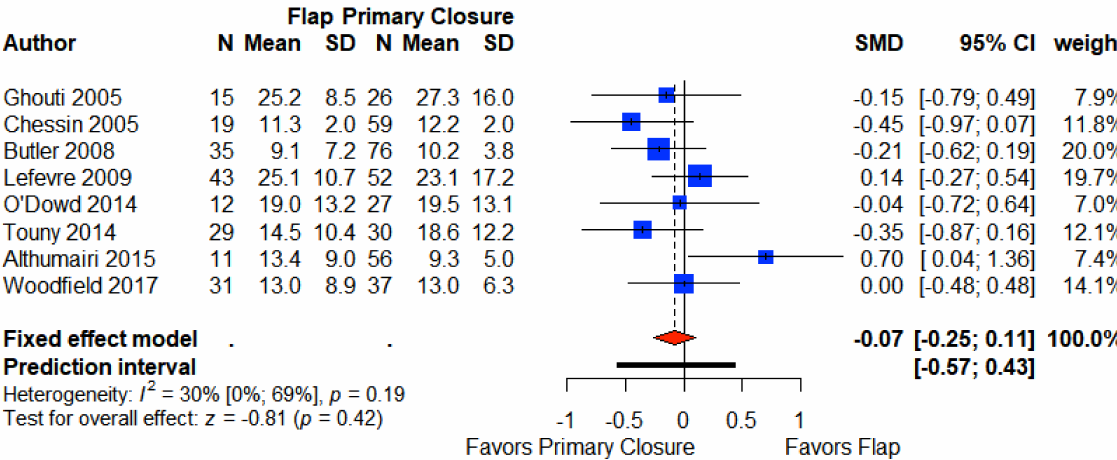
Figure 5. Forest plot for length of stay between patients with primary closure and with flap closure. Odds ratio: overall ratio of length of stay when comparing primary closure with flap closure. All weights are from random effects analysis. M–H, Mantel–Haenszel.